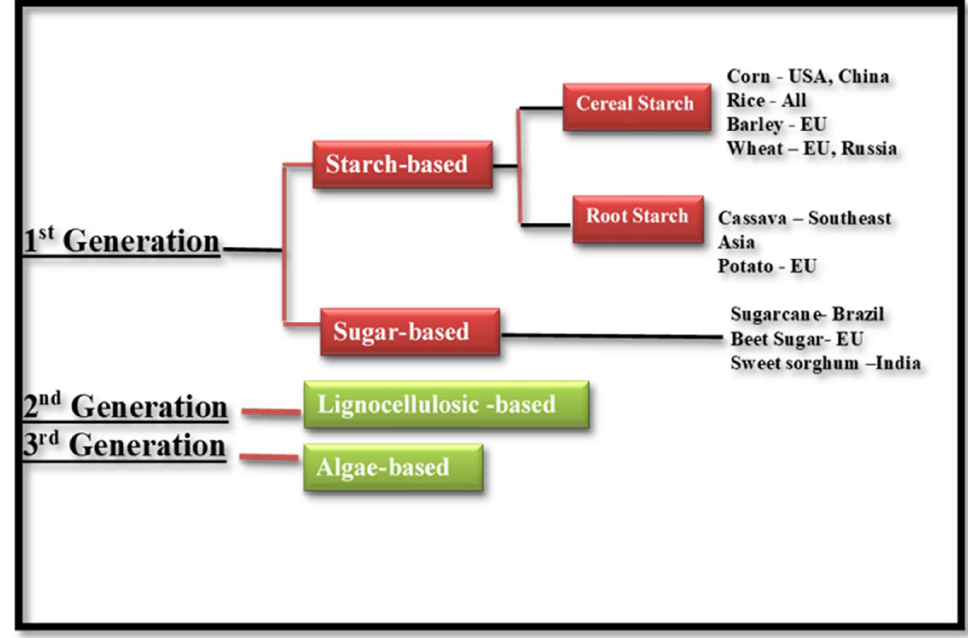
Figure 1. Raw materials used in the manufacturing of bioethanol in several nations (modified figure from Ref. [49]). from Ref.